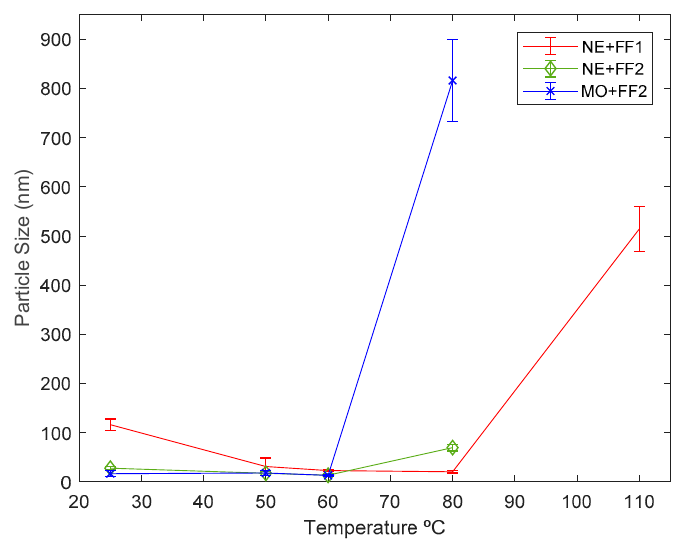
Figure 9. Average particle size of the DNF at the end of the testing period and error bar (i.e., 2 months for T > 30 °C and 10 months for T = 25 °C). FWHM is presented as the error bar.